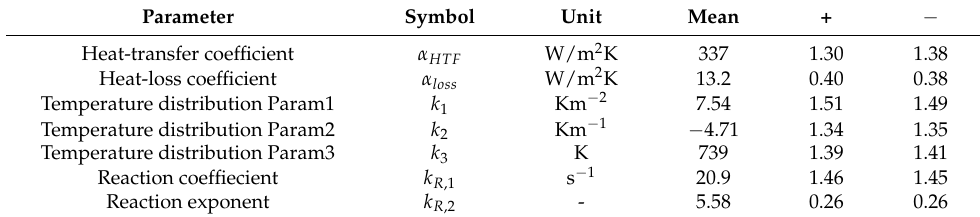
Figure 3. Histogramms for the parameter distribution after inverse modeling based on the experimental data of Reference [31]. On the diagonal are the histograms for the single parameters including mean and 95% confidence interval (indicated by the dashed lines). The scatter plots show the covariance between the parameters of the respective row and column. Table 6. Optimized set of parameters with mean 95% confidence